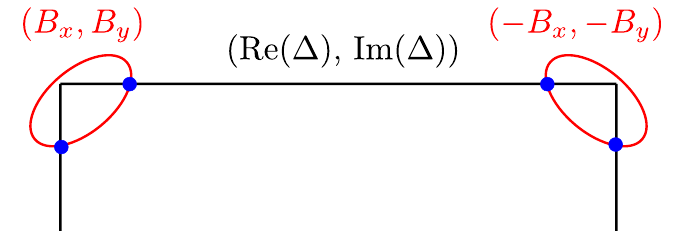
Figure 5: A qubit formed by four MZMs from adjacent corners. By tuning the Zeeman field B and the superconducting order ∆ one can achieve symmetry protected Clifford